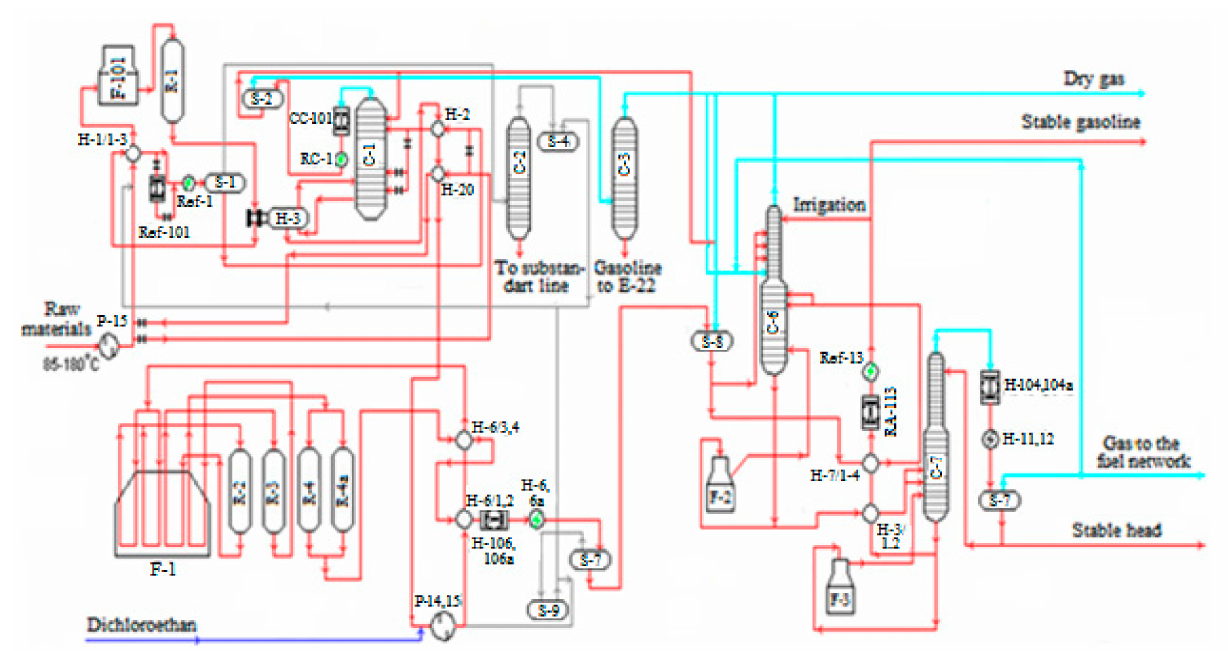
Figure 2. Process flow diagram of the LG-35-11/300-95 catalytic reforming unit. Technological lines: red—Petrol; grey—Technical hydrogen; Birch—Process gas;